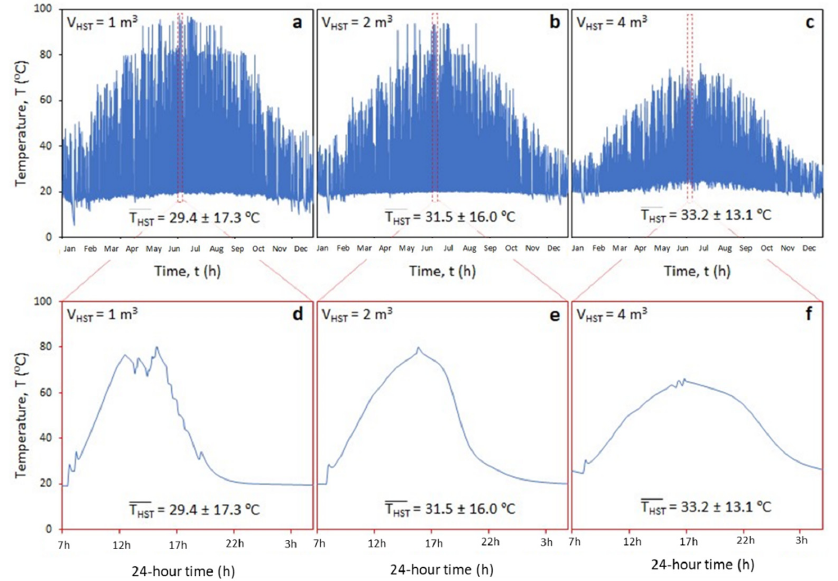
Figure 14. Simulated evolution of the HST outlet temperature for three winery case study scenarios without using latent heat storage based on PCM: ( a ) V HST = 1 m 3 , ( b ) V HST = 2 m 3 , ( c ) V HST = 4 m 3 . Figures ( d – f ) represent a zoomed version of ( a – c ), showing the temperature evolution of a specific calendar day, namely 17th June.